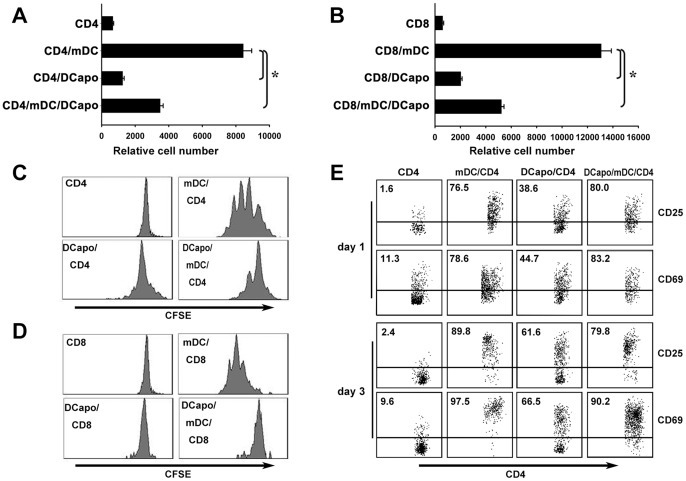
DCapos activated T cells but inhibited their proliferation.For CD4+ T cells, purified CD4+ T cells from DO11.10×C57BL/6 F1 hybrid mice (2×105 cells) stained with CFSE were co-cultured in vitro with OVA323–339-loaded mDCs (2×104 cells) in the presence or absence of DCapos (2×104 cells) for 4 days. For CD8+ T cells, purified OT1-CD8+ T cells (2×105 cells) stained with CFSE were co-cultured in vitro with OVA257–264-loaded mDCs (2×104 cells) in the presence or absence of DCapos (2×104 cells) for 3 days. (A) The cells were collected at 4 days, and both CD4- and KJ1-26-positive cells were counted using flow cytometry. (B) The cells were collected at 3 days, and both CD8- and Vβ5.1/5.2-positive cells were counted using flow cytometry. Histograms showed the mean ± SEM of triplicate wells counted using flow cytometry, and results represent 3 separate experiments. *p < 0.05. (C, D) The CFSE dilutions of CD4+ and CD8+ T cells were analyzed using flow cytometry. (E) Cells from different CD4+ T cell groups were collected and stained with anti-CD4, anti-CD25, and anti-CD69 mAbs for flow cytometric analysis. Data represent results of 1 of the 3 experiments performed to yield similar results.